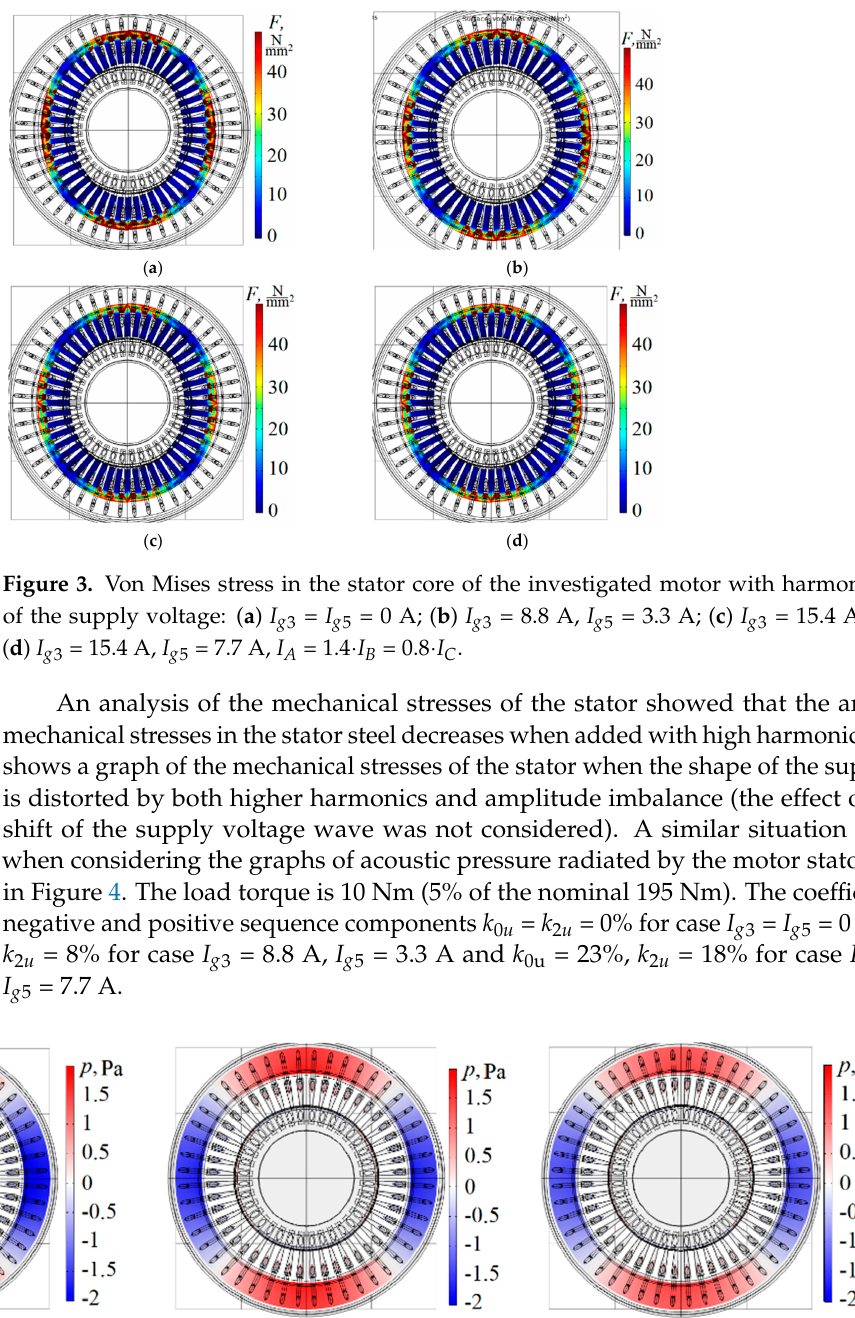
Figure 4. Acoustic radiation pressure of investigated motor with harmonic distortion of the supply voltage: ( a ) I g 3 = I g 5 = 0 A; ( b ) I g 3 = 8.8 A , I g 5 = 3.3 A ; ( c ) I g 3 = 15.4 A , I g 5 = 7.7 A .